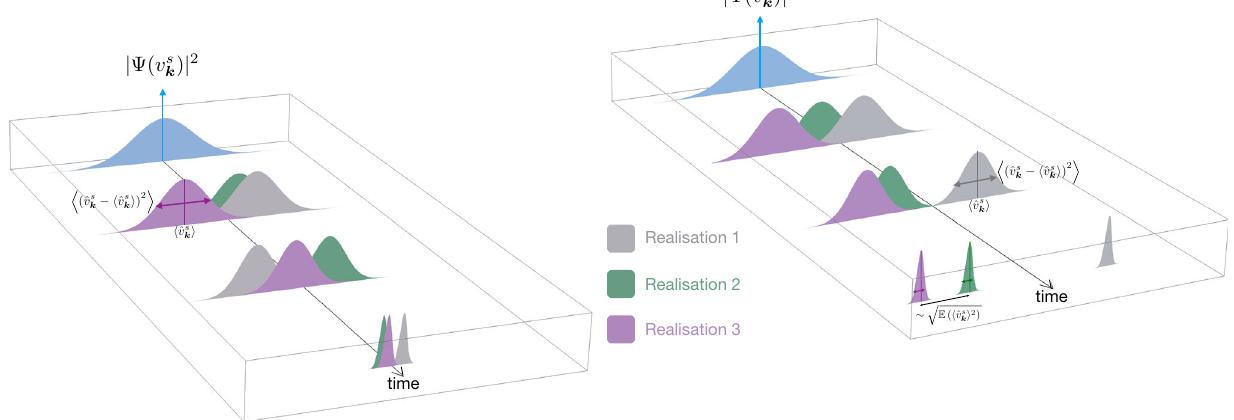
Fig. 1 In the framework of CSL, the wave-function of the perturba- continuously (and deterministically) decrease with time. At the final ) (where s = R , I denotes the real and imaginary parts of the (cid:4) 2 ] (the stochastic average of tions (cid:6)(v s time, the dispersion of the means, E [(cid:3)ˆ v s k k (cid:4)] = 0) is not small compared to the width Mukhanov-Sasaki variable v k ), taken to be a Gaussian in the context of the means vanishes E [(cid:3)ˆ v s k − (cid:3)ˆ v s (cid:4) ) 2 (cid:4)] = (cid:3) ( ˆ v s − (cid:3)ˆ v s (cid:4) ) 2 (cid:4) , and our inflation, is a stochastic quantity. As a consequence, its quantum mean of the wave-functions, E [(cid:3) ( ˆ v s k k k k (cid:4) and quantum dispersion (cid:3) ( ˆ v s −(cid:3)ˆ v s (cid:4) ) 2 (cid:4) are random variables. value (cid:3)ˆ v s criterion is not satisfied. In this case, the different wave-functions rep- k k k −(cid:3)ˆ v s (cid:4) ) 2 (cid:4) turns resenting different realisations are not sufficiently separated to account Inthepresentcase,however,thequantumdispersion (cid:3) ( ˆ v s k k for the emergence of different outcomes. In the right panel, on the con- out to be a deterministic function. In the left panel, we have represented trary, our criterion is satisfied and different realisations do correspond the stochastic “trajectories” of this wave-function for three different (cid:4) evolve randomly while the dispersions to well-separated realisations. The means (cid:3)ˆ v s k